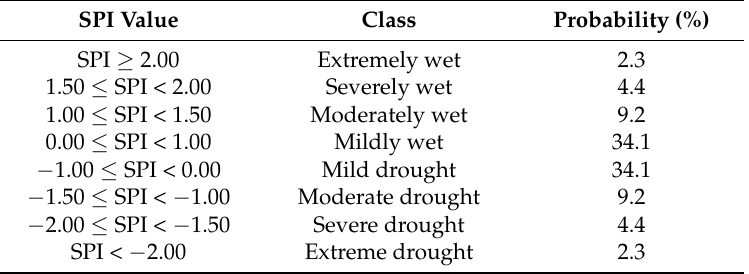
Table 1. Climate classification according to the Standardized Precipitation Index (SPI)